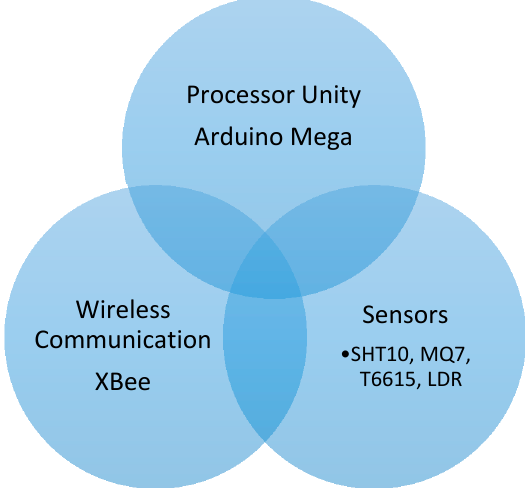
Figure 6. iAQ Sensor. Figure 6. iAQ